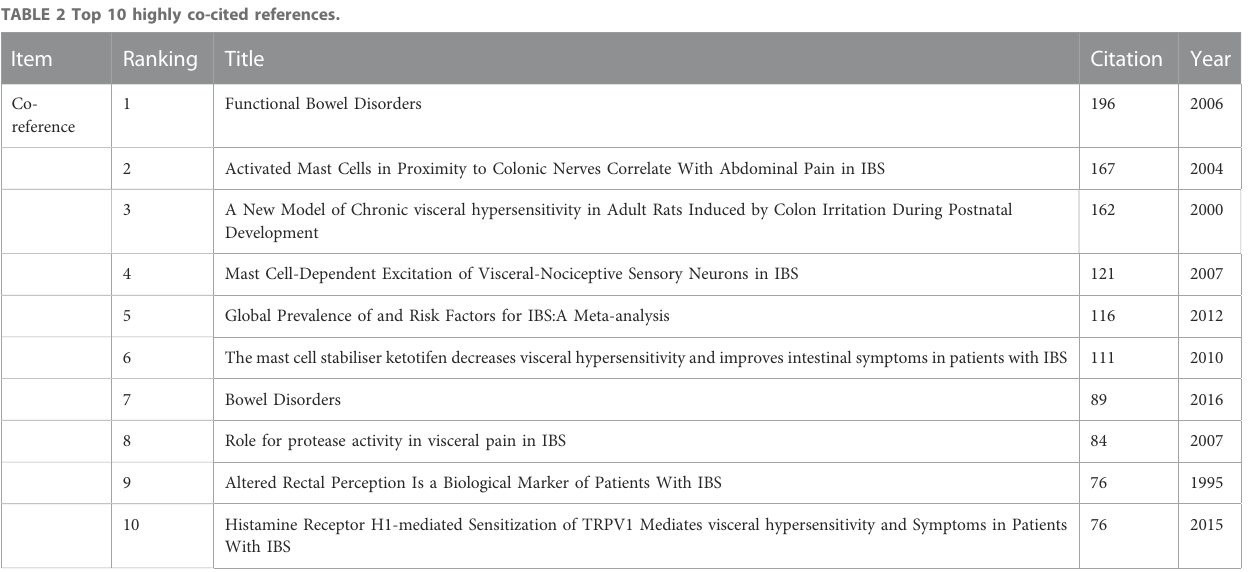
attention in the fi rst 20 keywords, outside of the pathogenesis keywords. Centrality represents the correlation between keywords. As shown in Table 4, the centrality of “ colonic motility ” ranks fi rst, followed by “ corticotropin-releasing factor, ” “ enteric nervous system, ” “ sensitivity ” and “ maternal separation. ” Notably, these keywords combined IBS with visceral hypersensitivity and related other studies.